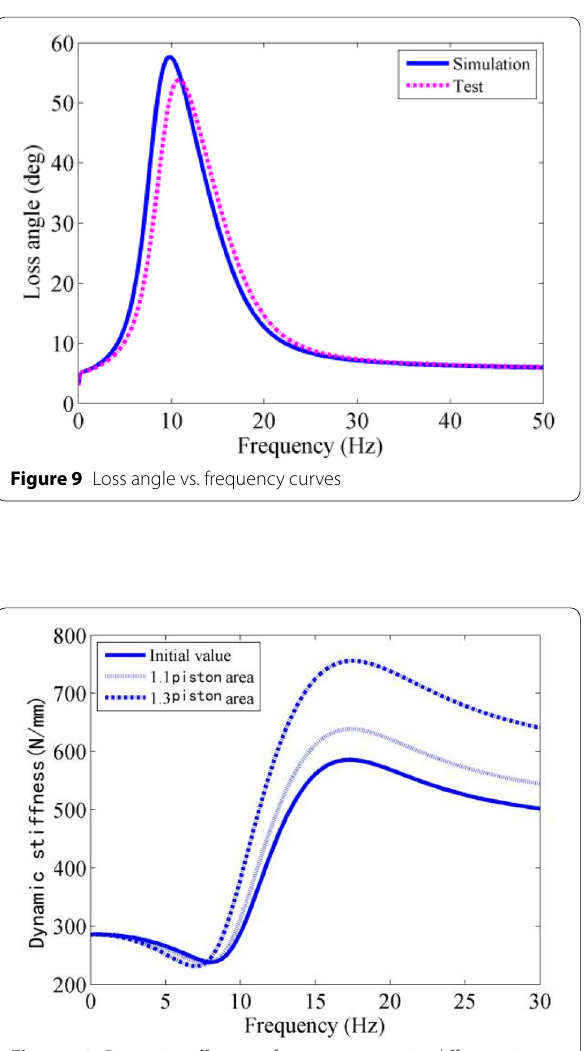
Figure 10 Dynamic stiffness vs. frequency curves in different piston